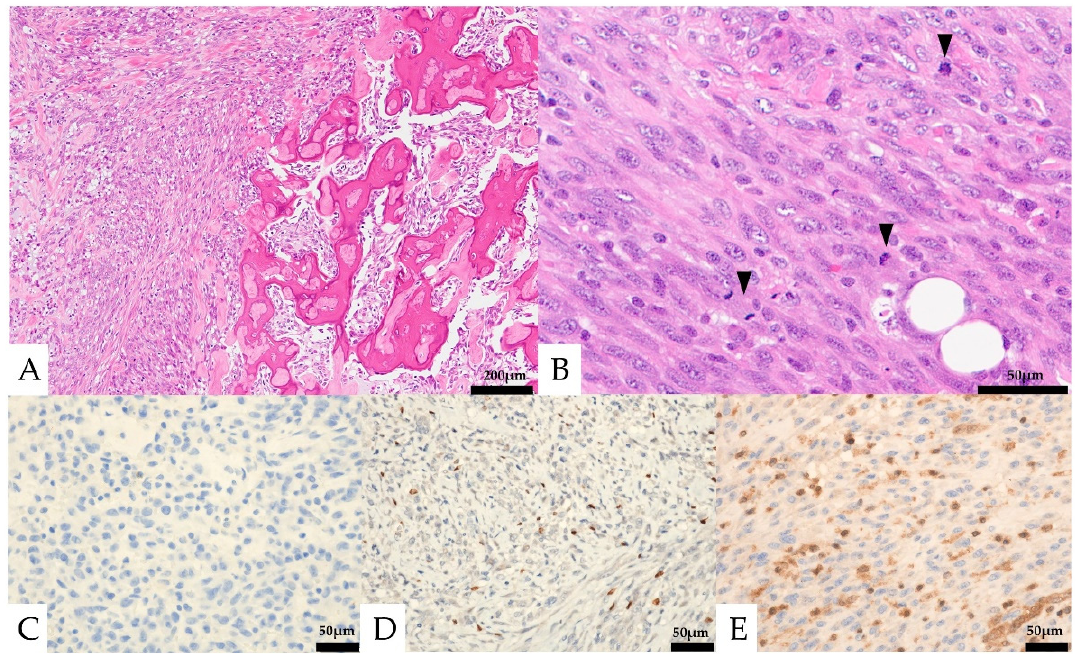
Figure 5. Pathological findings of the retroperitoneal specimen. ( A ) Osteoid formation was seen in part of the tumor (right). ( B ) Only mononuclear cells were seen. Mitotic figures were frequently seen (black arrows). ( C – E ) Immunohistochemical features: the mononuclear cells were negative for CK AE1/AE3 ( C ) and focal positive for SATB2 ( D ), and loss of MTAP expression was seen in the mononuclear cells ( E ).